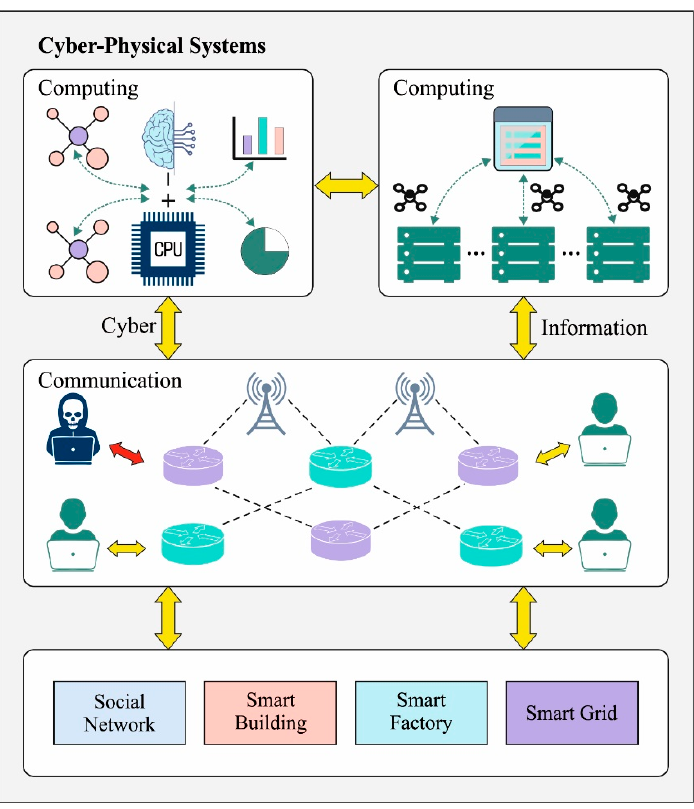
Figure 1. CPS and potential security threats.